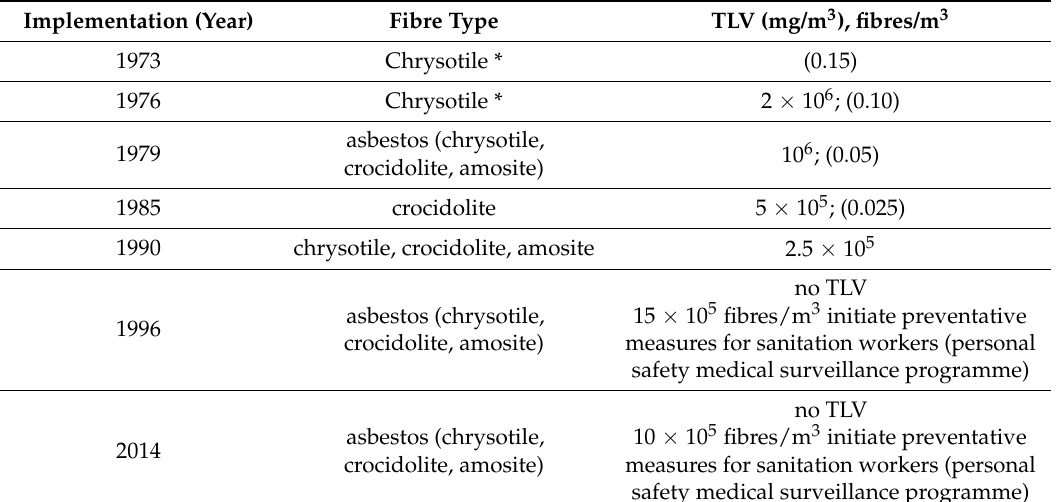
Table 1. Stepwise reduction of the German asbestos threshold limit value